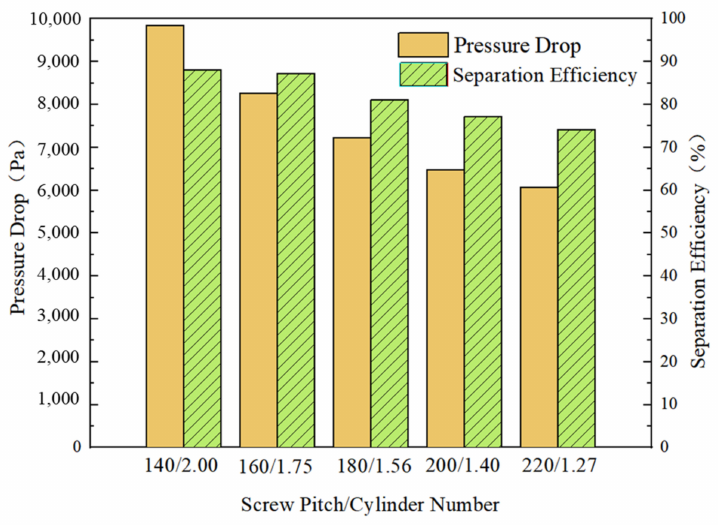
Figure 2. Separation Efficiency and Pressure Drop of Fixed-pitch Cyclone